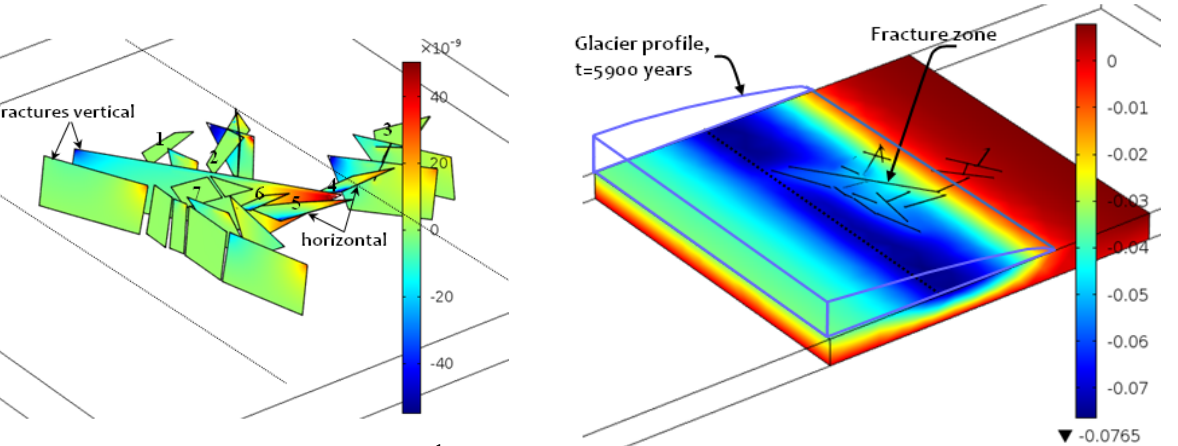
Figure 10. Distribution of the vertical fluid velocity [ms − 1 ] within the fracture zones at time 5900 years. The rock mass is subjected to spatially non-uniform fluid pressure and compressive stress im- posed by the advancing glacier. Subhorizontal fractures are num- bered 1–7.